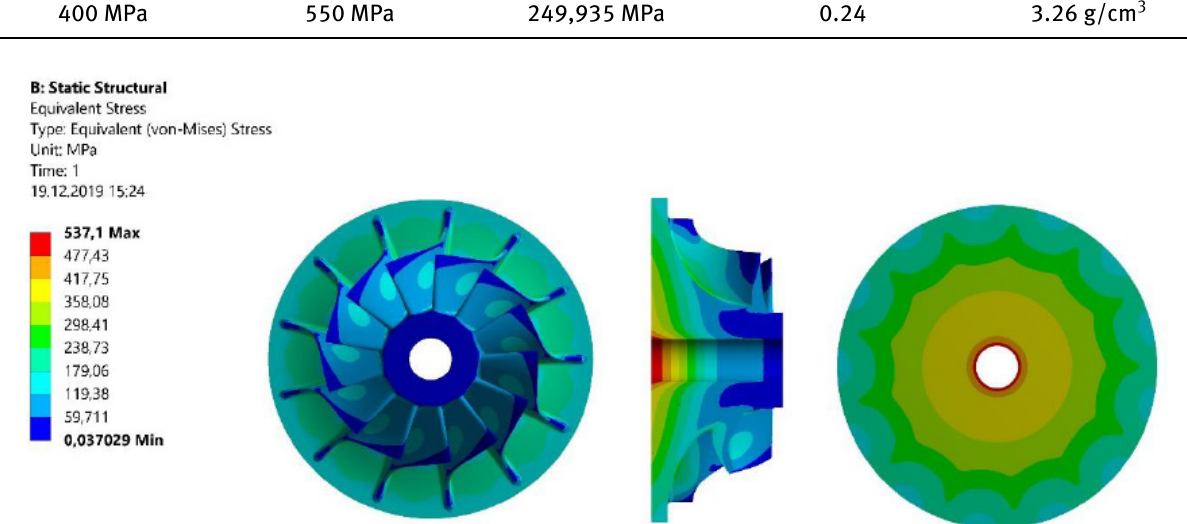
Table 3: Mechanical properties of silicon nitride at 600 ∘ C Yield strength